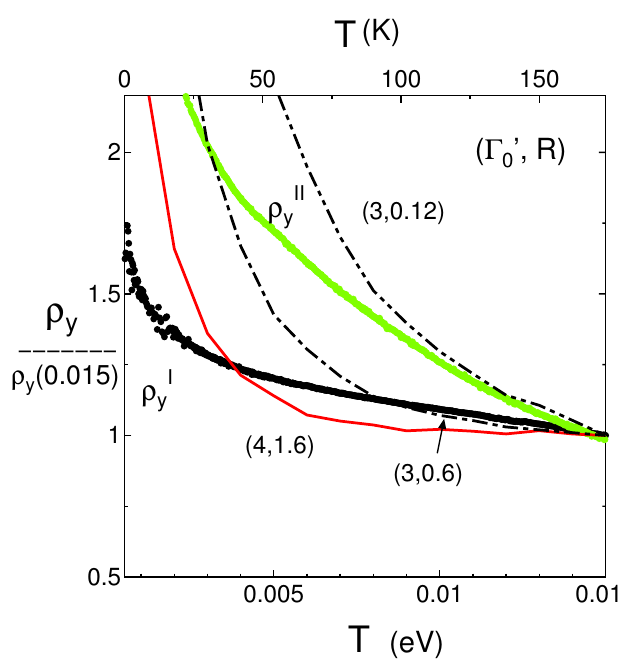
Figure 7. (Color online) T dependence of ρ y (= 1/ σ y ) normalized by the value at T = 0.015 eV (174 K) in the interval range of 0.0005 eV < T < 0.015 eV. The quantities ρ I and ρ II denote the normalized resistivity at P = 12.6 GPa [10] and 13 GPa [40] respectively, which are compared with those of ( Γ (cid:48) , R ) = ( 4,1.6 ) , ( 3,0.6 ) , and ( 3,0.12 ) . The line (4, 1.6) stays almost constant at high 0